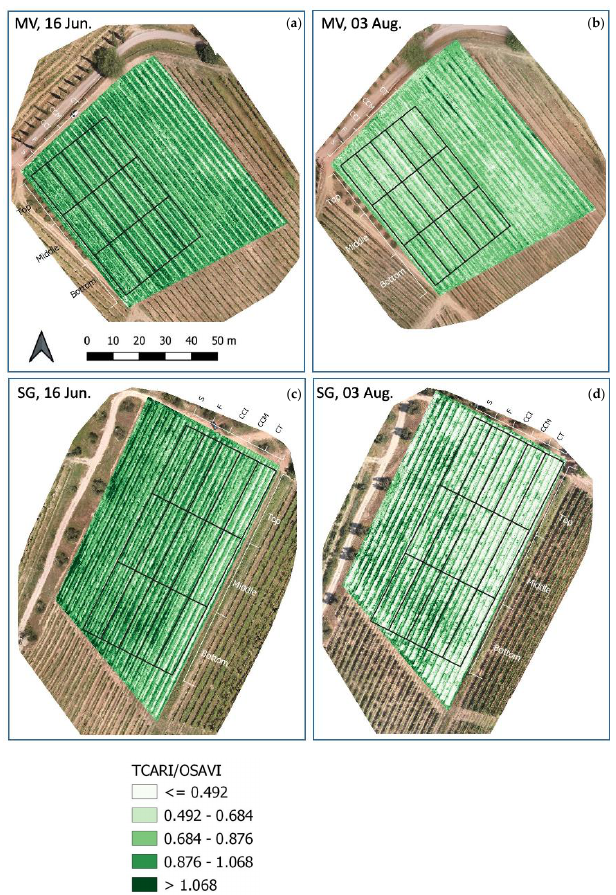
Figure 7. TCARI/OSAVI maps of June and August 2018 for MV ( a , b ) and SG ( c , d ).